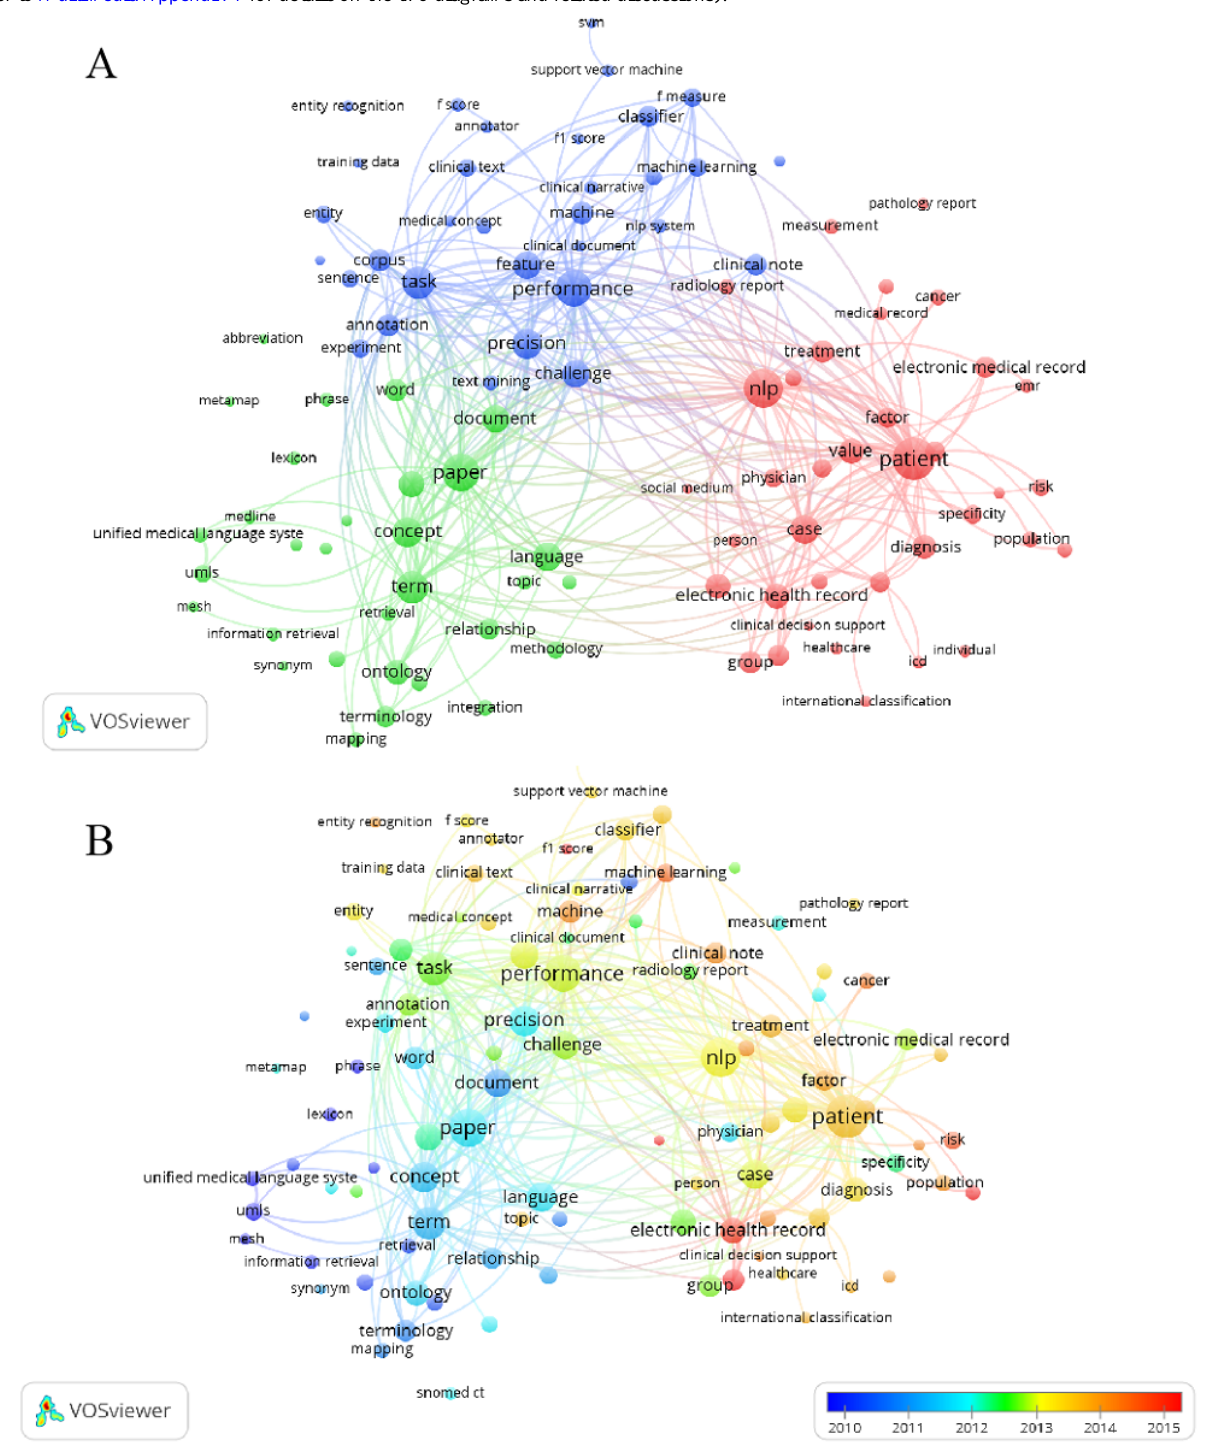
Figure 5. (A) Distribution of keywords. A circle represents an identified keyword, the size of the circle represents the importance, and the thickness of the link connecting the circles represents the relatedness of the connections among the keywords. Circles with the same color belong to the same cluster. (B) Changes in keywords over time. A color closer to blue represents an earlier time and closer to red represents a time closer to 2018 (note: refer to Multimedia Appendix 1 for details on the two diagrams and related